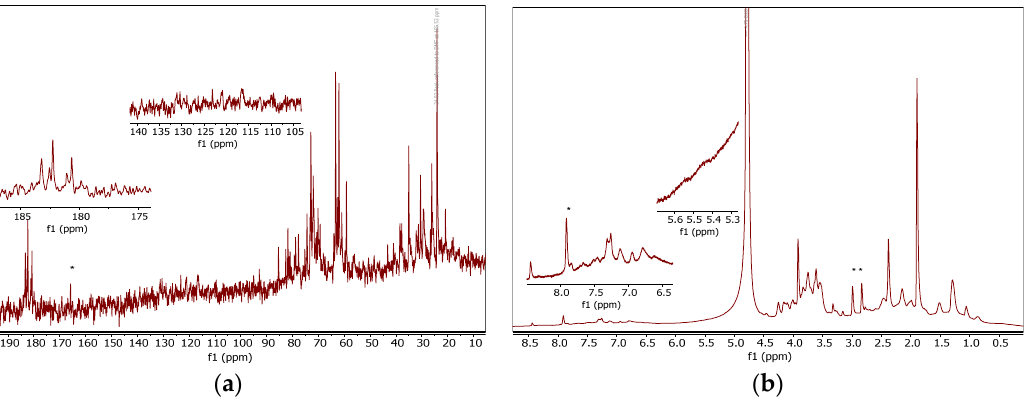
Figure 5. ( a ) 13 C NMR and ( b ) 1 H NMR spectra of WP-CDs-5 in D 2 O (32.5 mg/mL). Insets: Expanded regions of interest. Signals from DMF (5 mM), used as internal standard, are indicated by an asterisk (*).